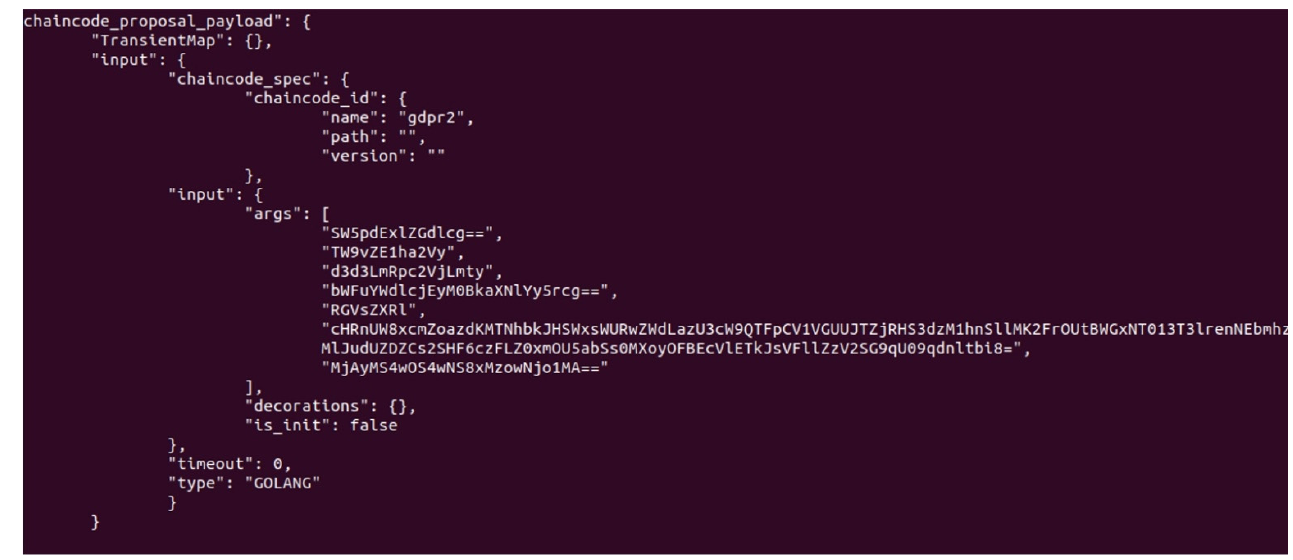
Figure 12. A transaction in a saved block viewed by peers.